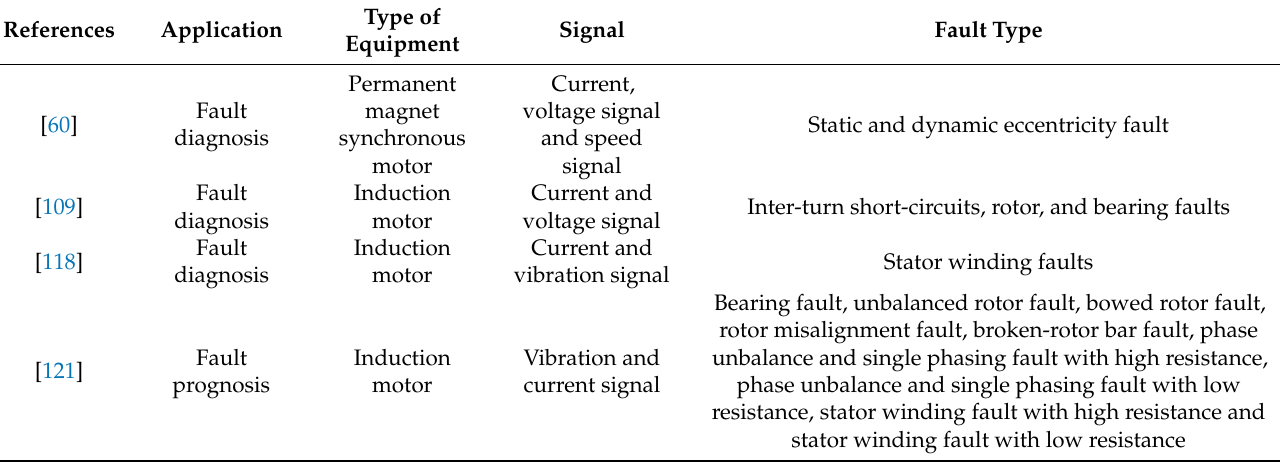
Table 13. Motor condition monitoring using support vector machine.